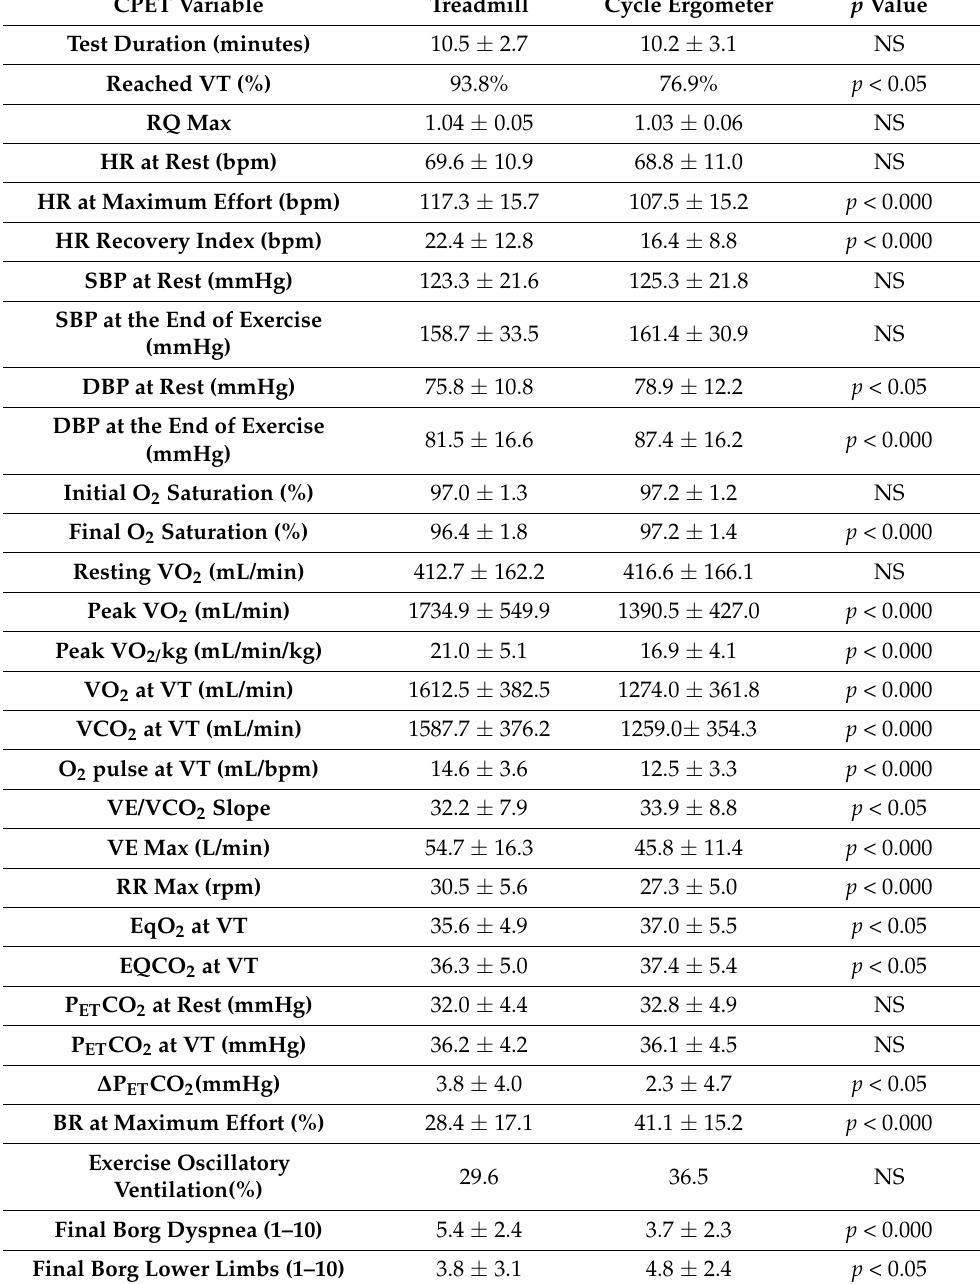
Table 2. Cardiopulmonary exercise testing